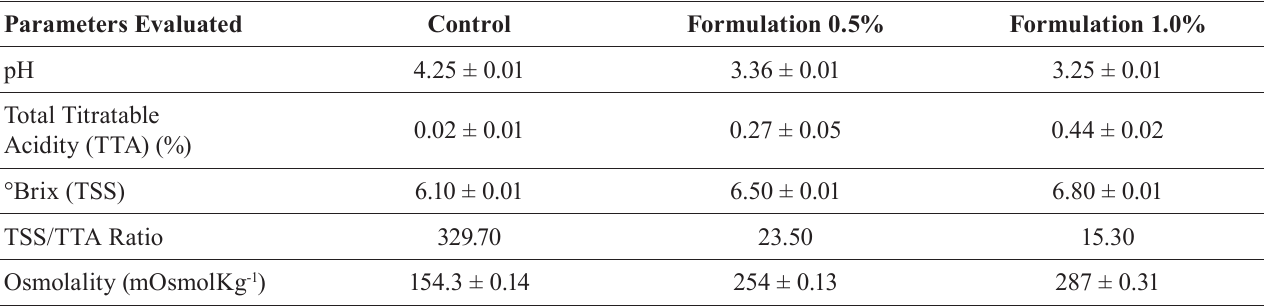
TABLE II - Results of the physicochemical characterization of the beverage formulations developed with 0.5 % and 1.0 % of bacaba peel extract and control